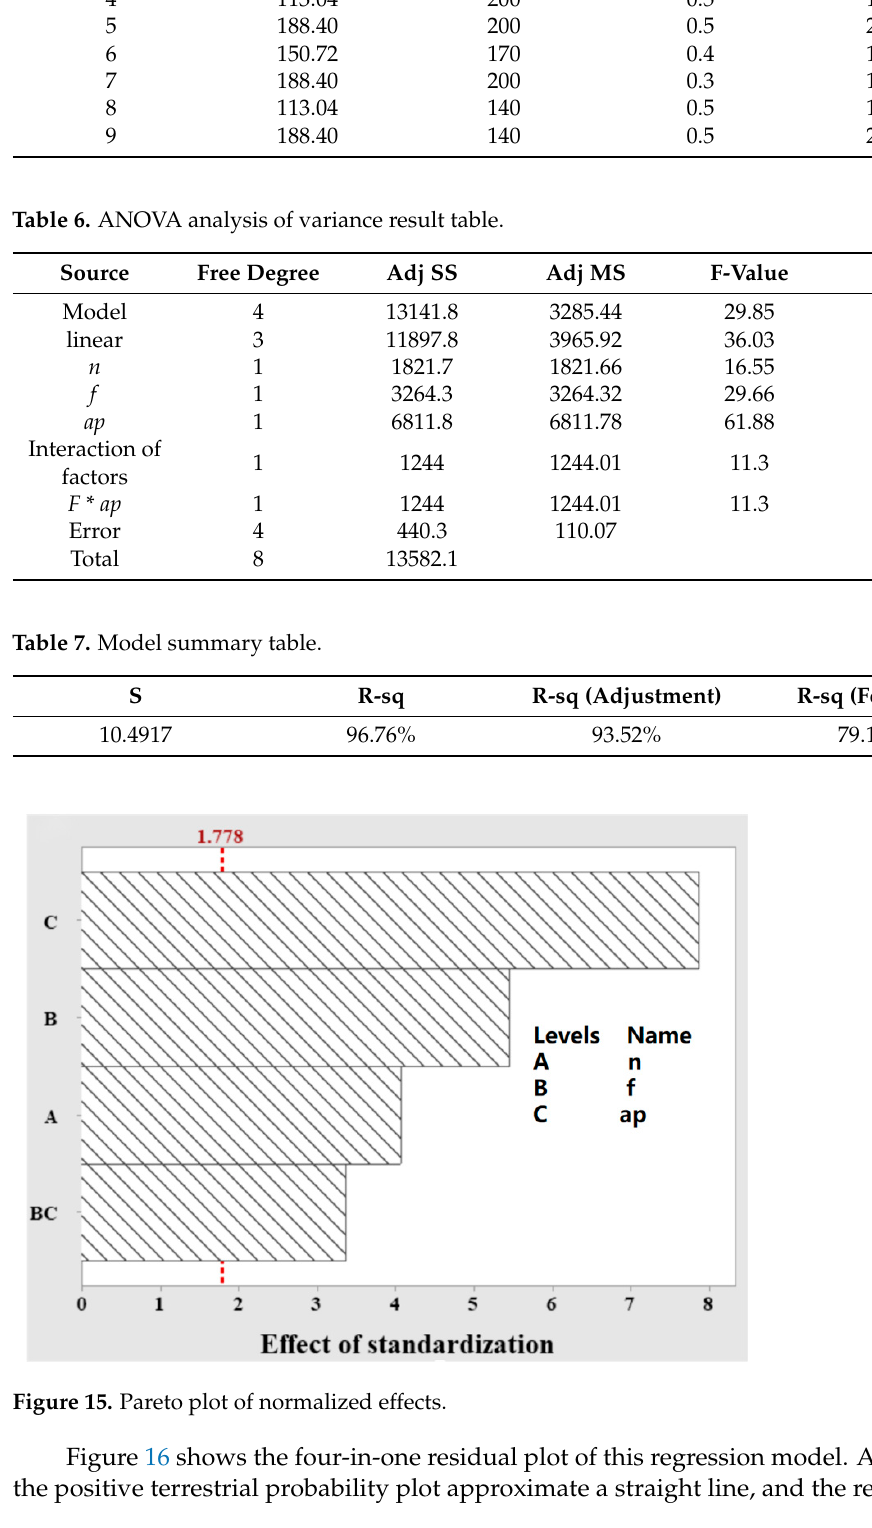
Table 5. Comprehensive test results. Serial Number